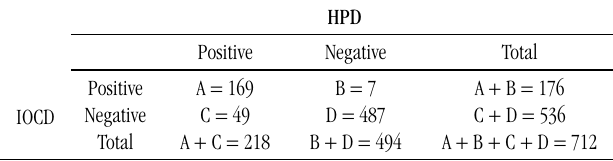
taBLE 4 – Distribution of benign and malignant diagnoses made at IOC and by histopathological